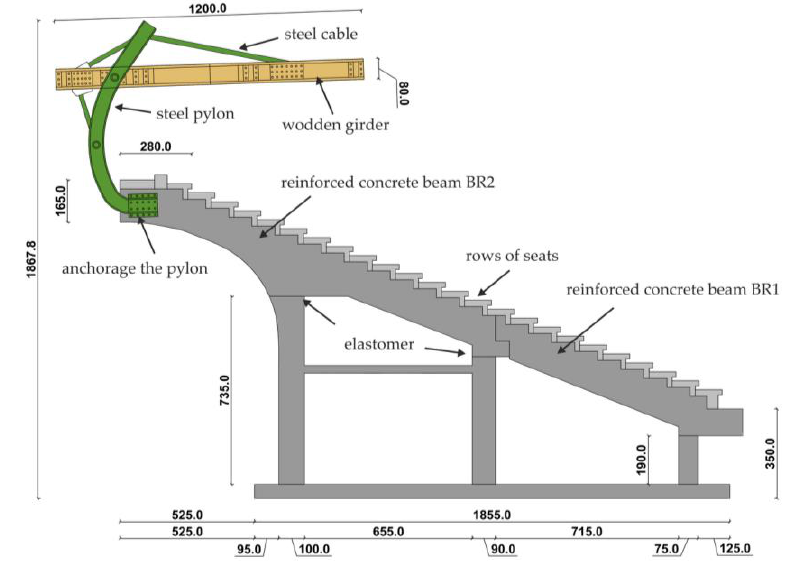
Figure 3. Cross-section of the stand (dimensions in cm) .